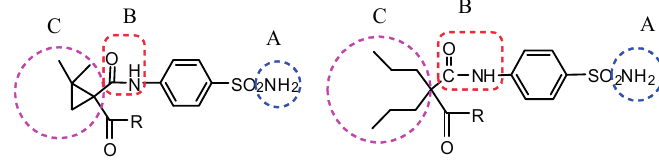
Figure 2. Pharmacophoric structure of designed compounds.